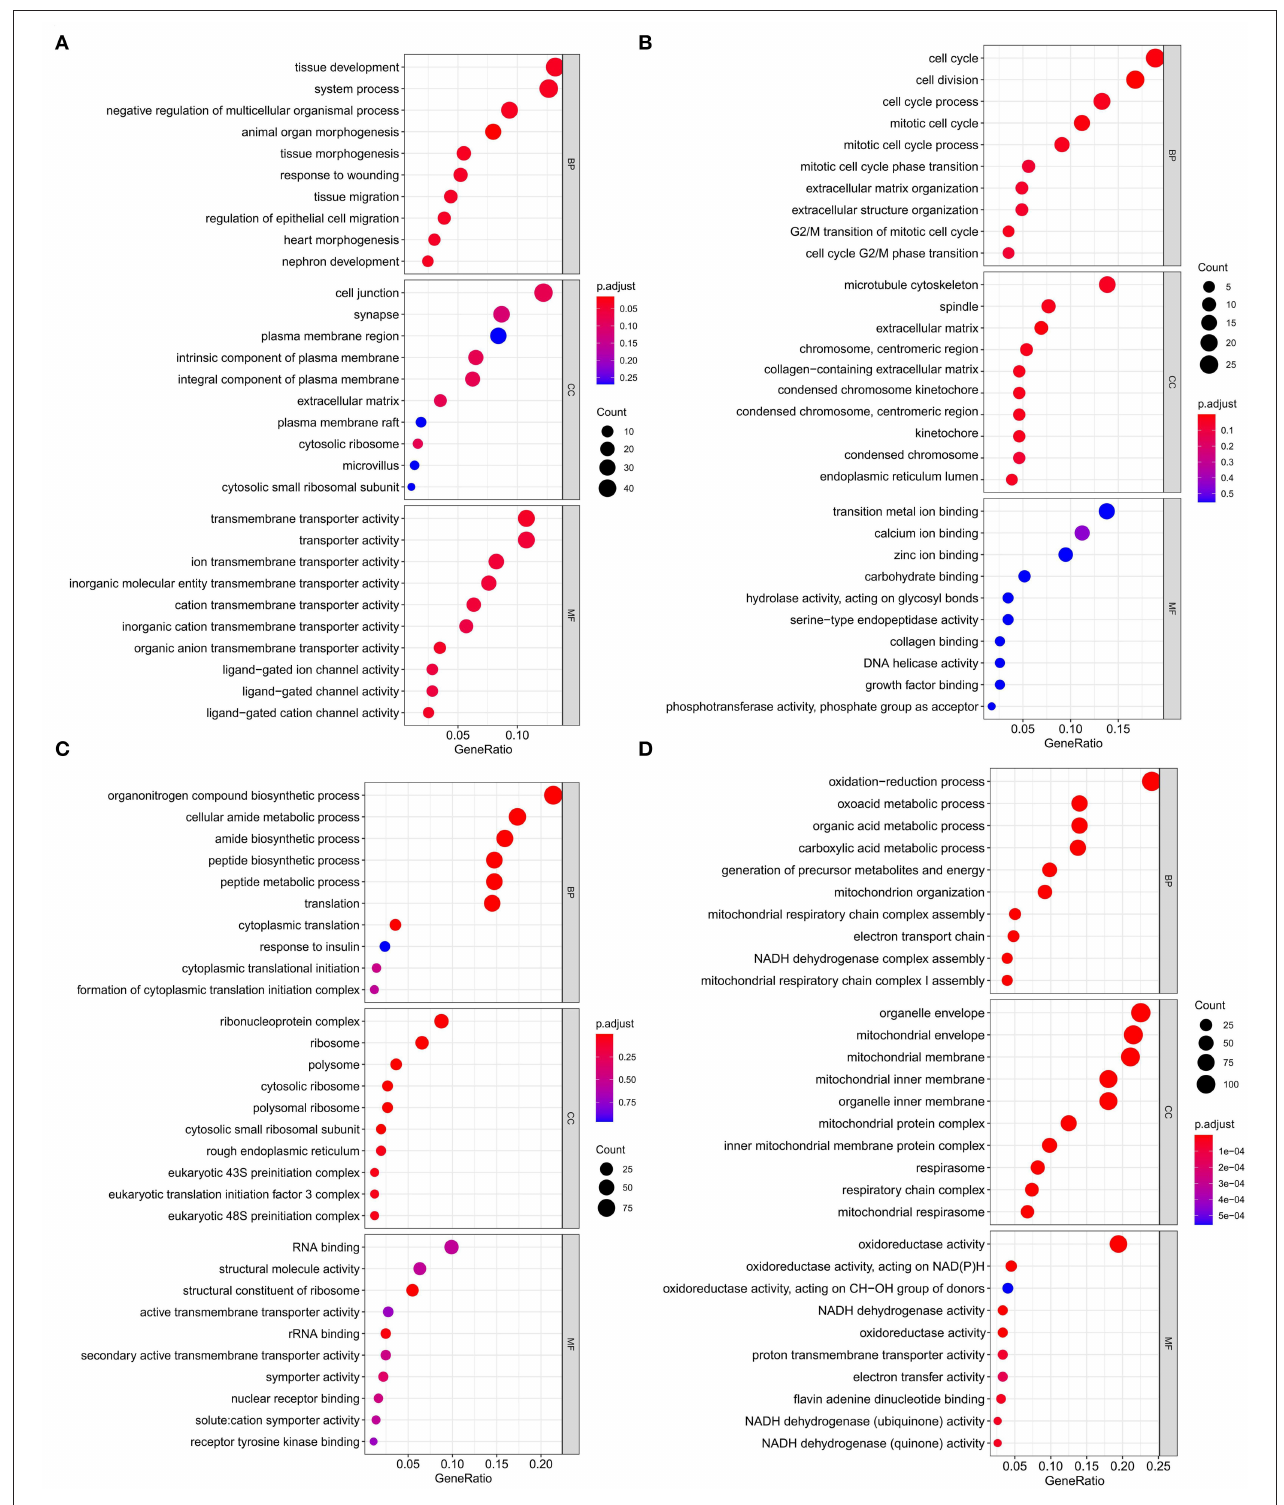
FIGURE 5 | Gene ontology enrichment analysis of modules that are most associated with nutrient levels. In subcutaneous adipose tissue, genes from the blue and yellow modules that significantly related to low nutrition (A) , and high nutrition (B) were analyzed. In visceral adipose tissue, genes from the blue and brown modules that significantly related to low nutrition (C) , and high nutrition (D) were analyzed. The top 10 significant enriched GO terms were shown.